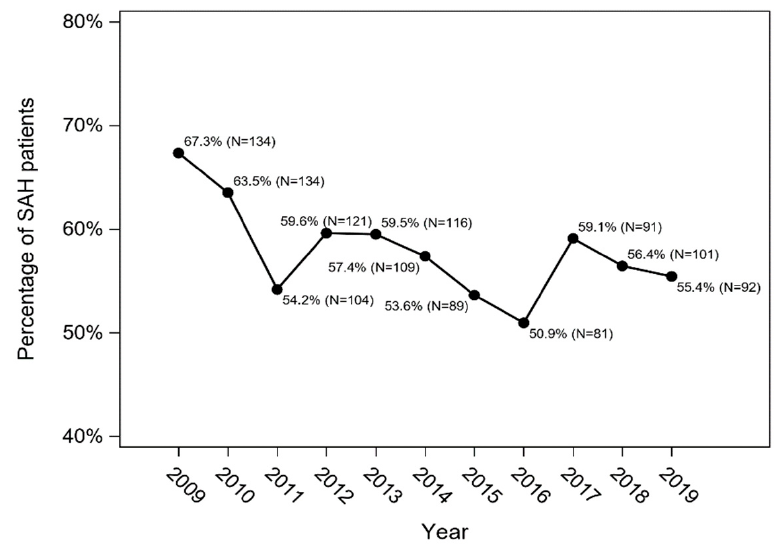
Figure 2. Percentage of SAH patients hospitalized in the neurosurgical departments of the Silesian Province between 2009 and 2019 (Cochran–Armitage trend test: p = 0.009).